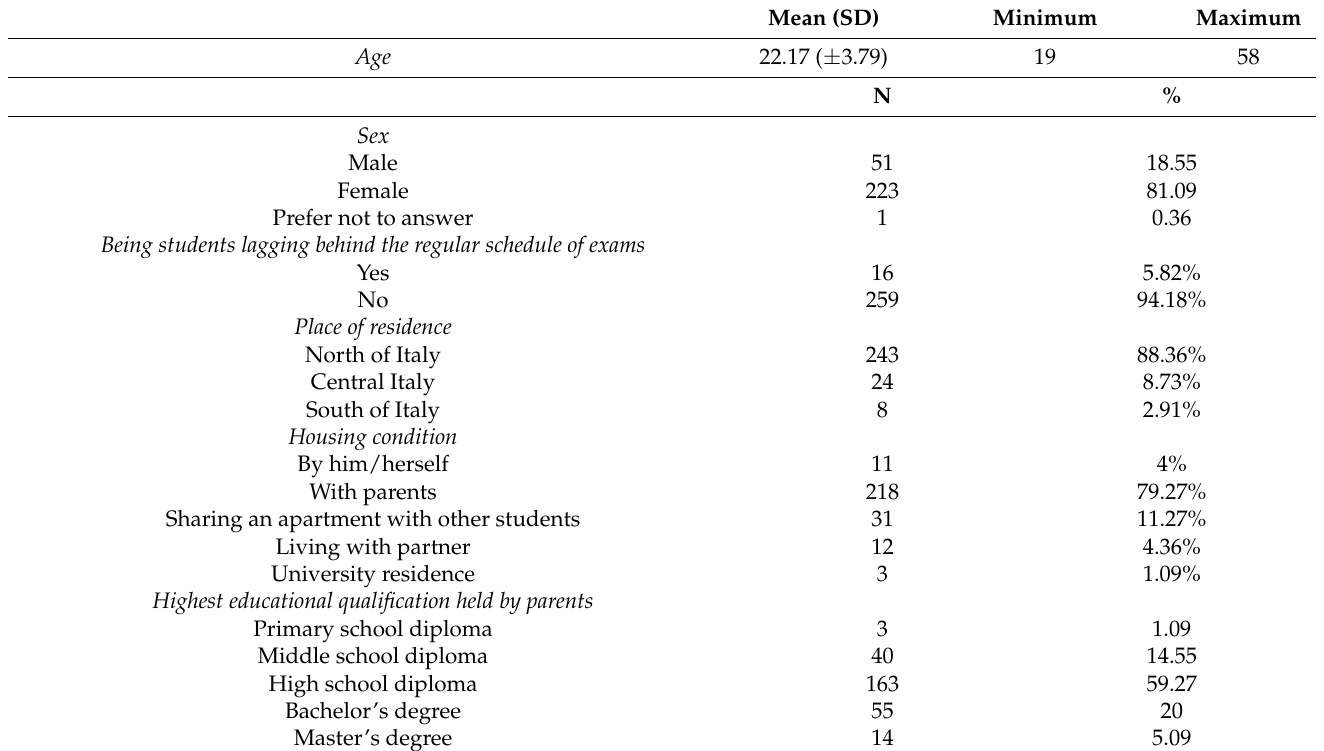
Table 1. Socio-demographic characteristics of the